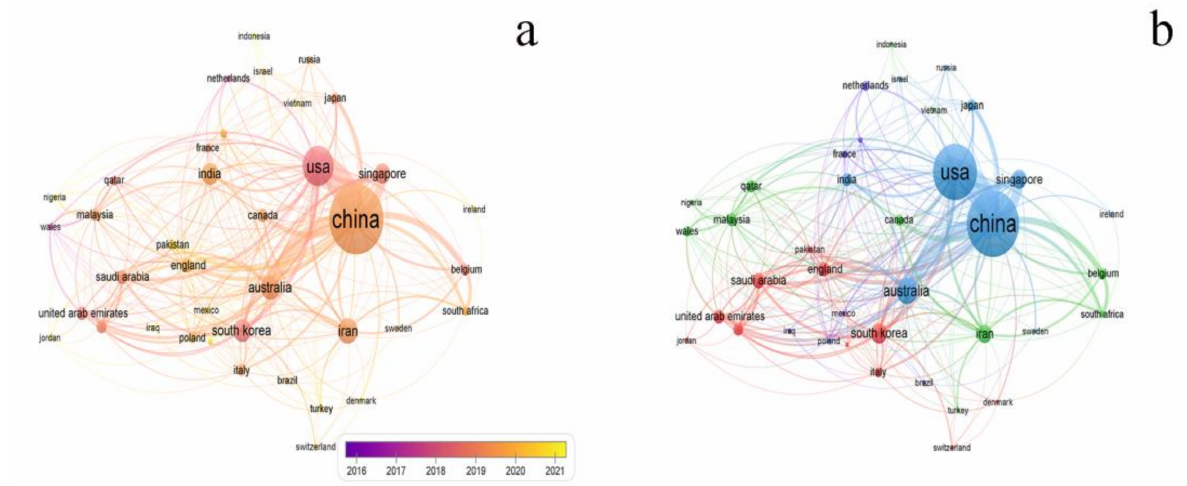
Figure 3. ( a ) The network of the top 40 countries. Each country on the map was displayed as a node, with size determined by the number of publications. Country relationships were shown as edges of varying thickness determined by the co-occurrence. The node color was determined by the publication time; ( b ) the network of publication distribution by countries in terms of citation scores. The node size was determined by the citation scores.